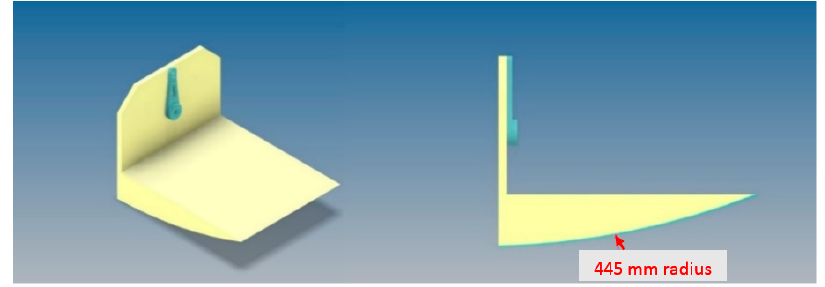
Figure 7. Proposal of a robot effector.